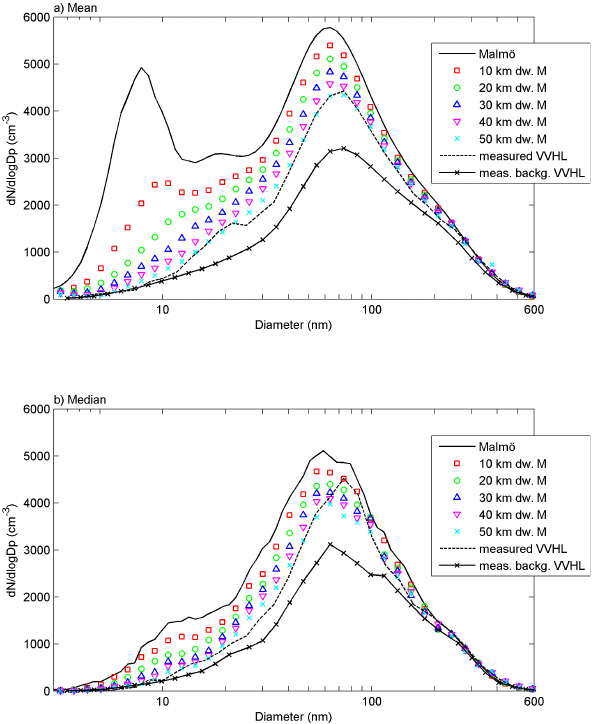
Fig. 3. Modeled average (a) and median (b) particle number size distributions in the center of the urban plume, 10, 20, 30, 40 and 50km downwind of Malm¨o, together with the measured particle number size distributions in Malm¨o and at Vavihill (50km down- wind of Malm¨o). The displayed size distributions in Malm¨o were derived from the SMPS measurements applying the lognormal fit- ting algorithm from Hussein et al. (2005) for each individual size distribution and then taking the average and median of these size distributions.